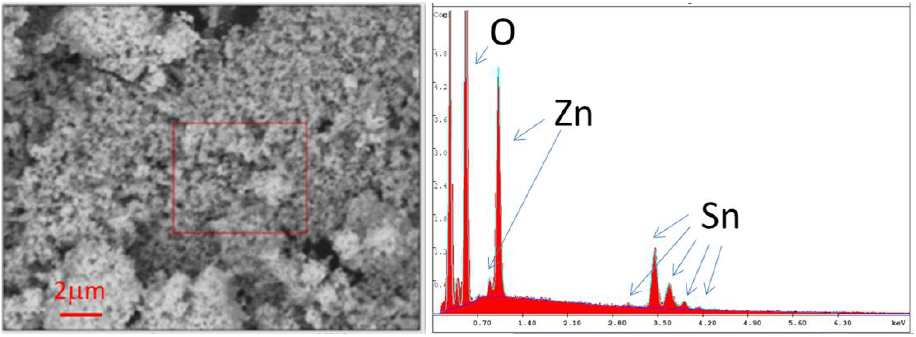
Figure 4. EDS analysis and spectrum for synthesized ZHS.